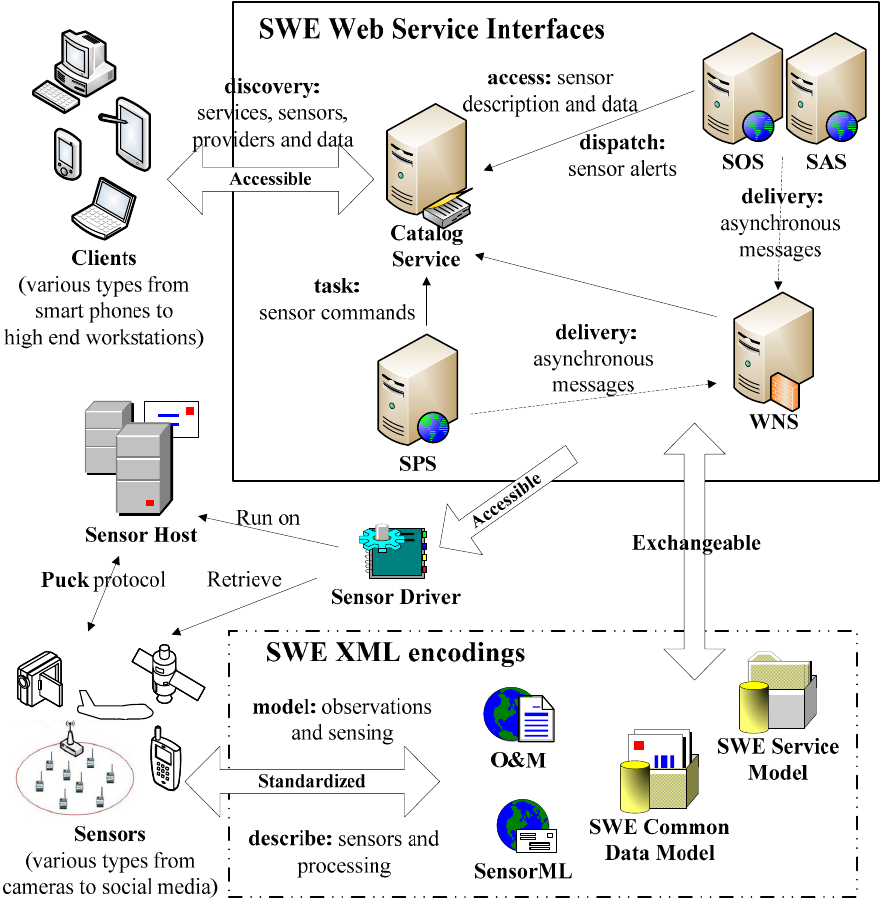
Figure 1. Components in the Sensor Web Management Framework.